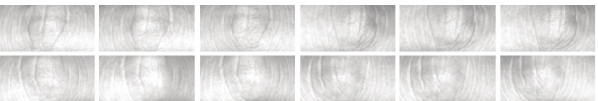
Figure 4: Twelve sample images of one subject in the FKP